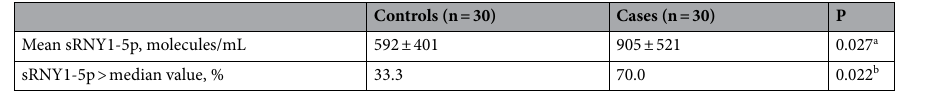
Table 2. Serum levels of sRNY1-5p at baseline. Serum sRNY1-5p levels were measured at baseline (i.e. when individuals were first included in the GENES cohort). Values are expressed as mean ± SD or percentage. a Paired Student’s t-test. b McNemar’s test.